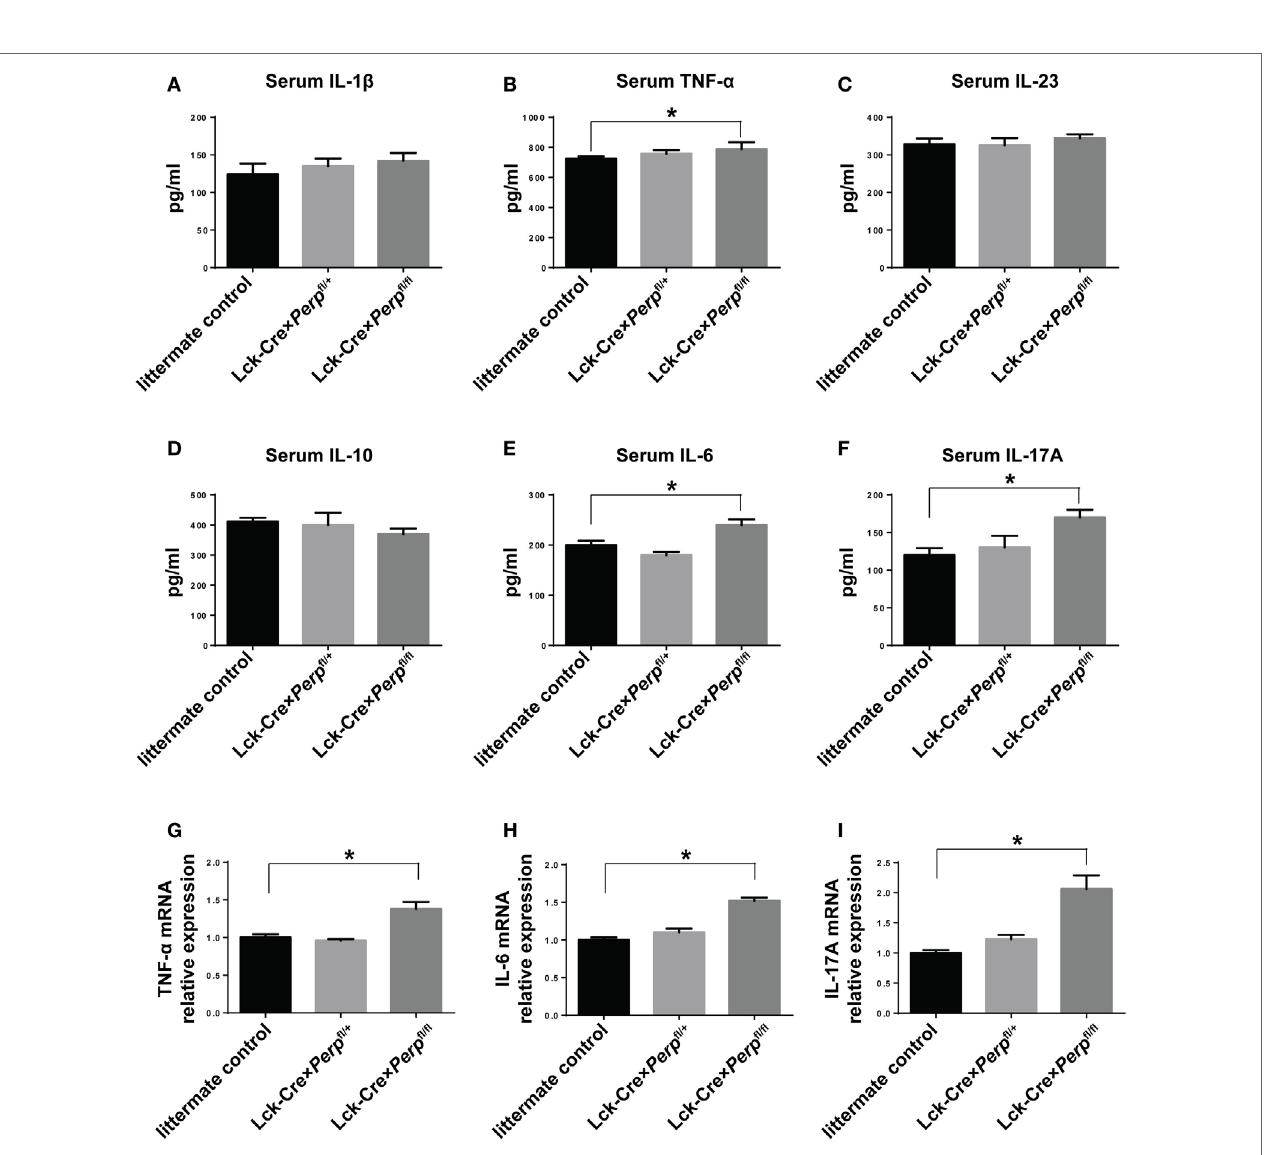
FigUre 5 | Perp − / − in T cells increases the levels of pro-inflammatory cytokines in mice following induction of experimental autoimmune encephalomyelitis. At 23 days post-induction, peripheral blood samples and central nervous system tissues were obtained from individual mice. The relative levels of serum IL-1 β (a) , TNF- α (B) , IL-23 (c) , IL-10 (D) , IL-6 (e) , and IL-17A (F) were determined by ELISA. The relative levels of TNF- α (g) , IL-6 (h) , and IL-17A (i) mRNA transcripts to GAPDH were determined by quantitative real-time PCR. Data are expressed as the mean ± SEM of each group ( n = 8 per group) from three separate experiments (* P < 0.05).